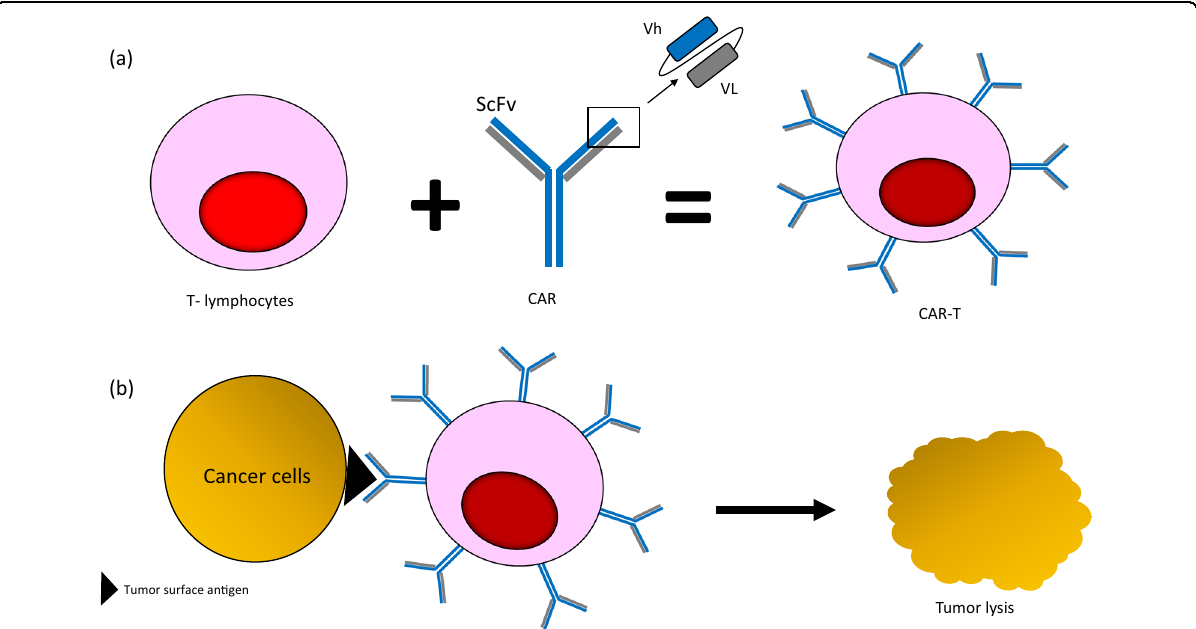
Fig. 2 The basic principle of CAR T-cell therapy. a T lymphocytes are genetically modi fi ed to express chimeric antigen receptor which is made up of monoclonal antibody targeting speci fi c antigen of interest. ScFV Single chain variable fragment, Vh Heavy chain, VL Light chain. b ScFV portion of CAR T cell recognizes tumor-associated antigen on the surface of tumor cells, binds to them, and initiates a cascade of cytotoxic signaling, leading to tumor